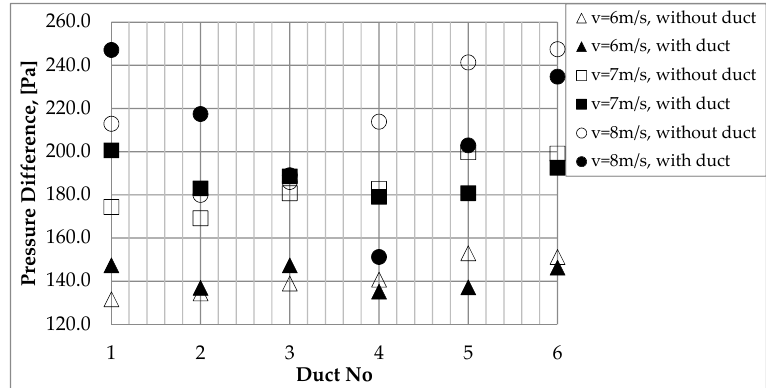
Figure 10. Maximum pressure differences between the inlet and outlet of the air ducts.